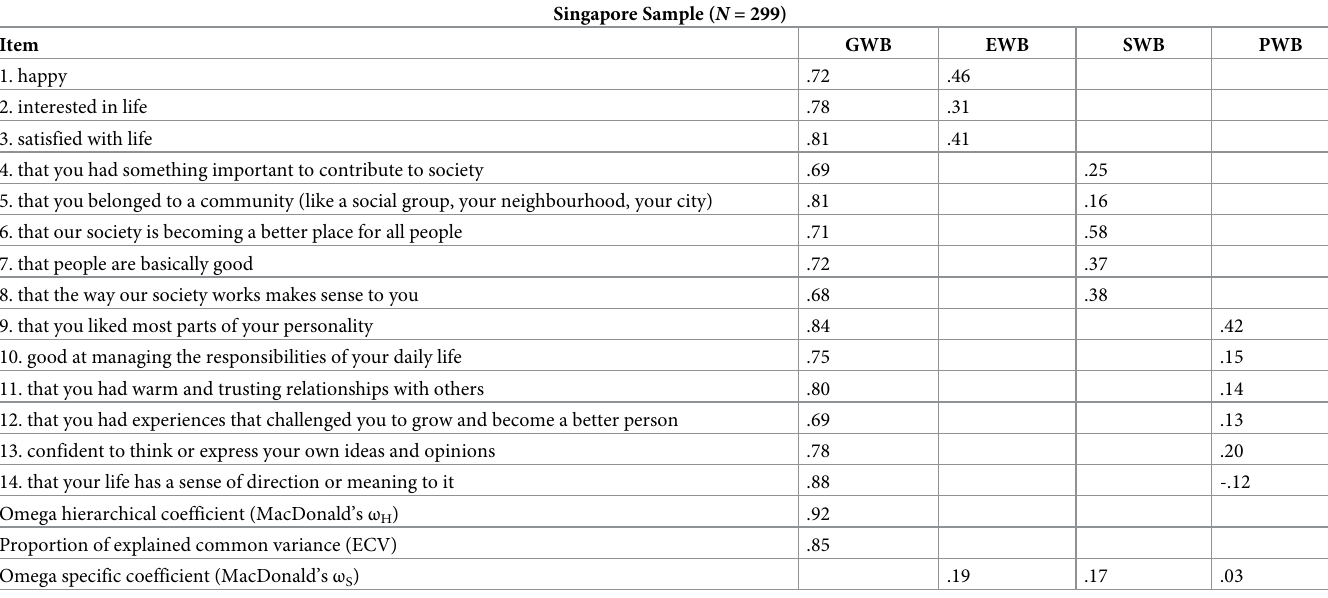
Table 5. Standardised factor loadings, Macdonald’s omega hierarchical and specific coefficients, and explained common variance of the bifactor model of the MHC-SF (Singapore